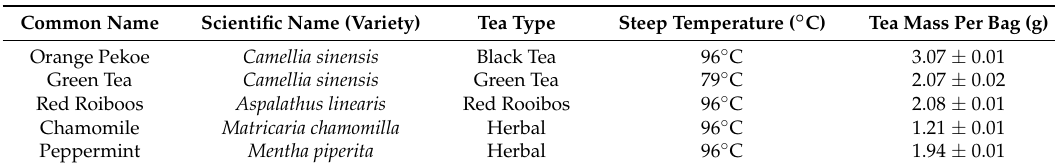
Table 1. Origin and description of teabag samples.